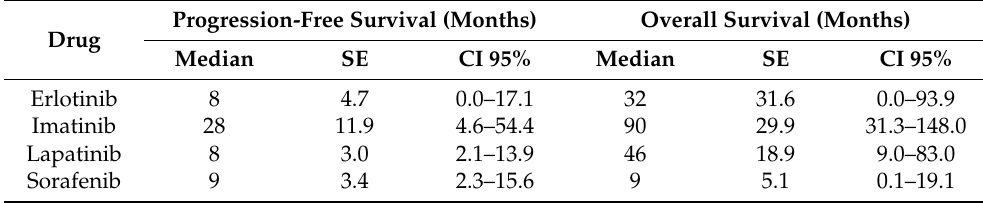
Table 3. Survival